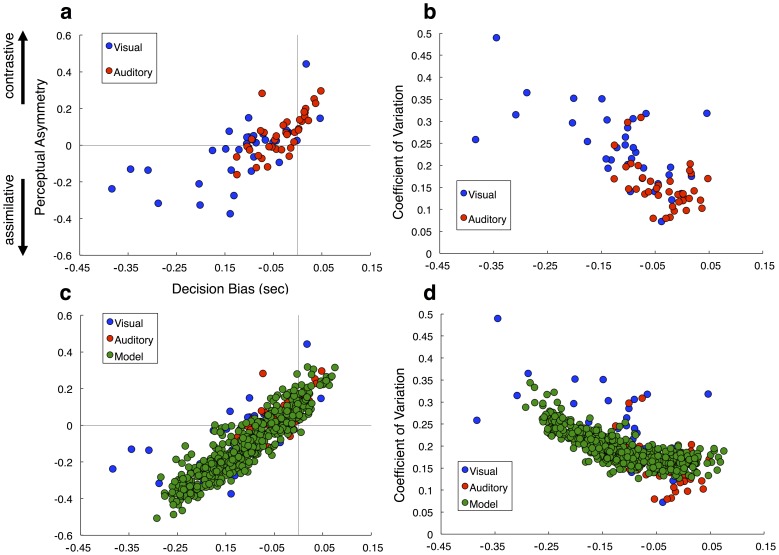
Relationship between decision bias and perceptual influence in individual participants.(a) Correlation between decision bias, defined as the signed difference between prior(long) and prior(short) bisection points, and perceptual asymmetry, defined as the slope of the best fitting regression line through bisection points for each prior interval condition; negative slopes indicate assimilative effects whereas positive slopes indicate contrastive effects. Smaller decision bias (closer to zero) was associated with greater contrastive perceptual effects, whereas greater decision bias (more negative) was associated with assimilative effects. Auditory and visual participants occupied separate quadrants, with greater decision bias for visual stimuli and greater perceptual contrast for auditory stimuli. (b) Correlation between decision bias and mean session coefficient of variation (CV); greater decision bias was associated with a larger CV. (c, d) Auditory and visual participant data with model performance from 500 permutations overlaid for both correlations from above. The model was able to account for a wide variety of performances that encompassed the majority of participants.